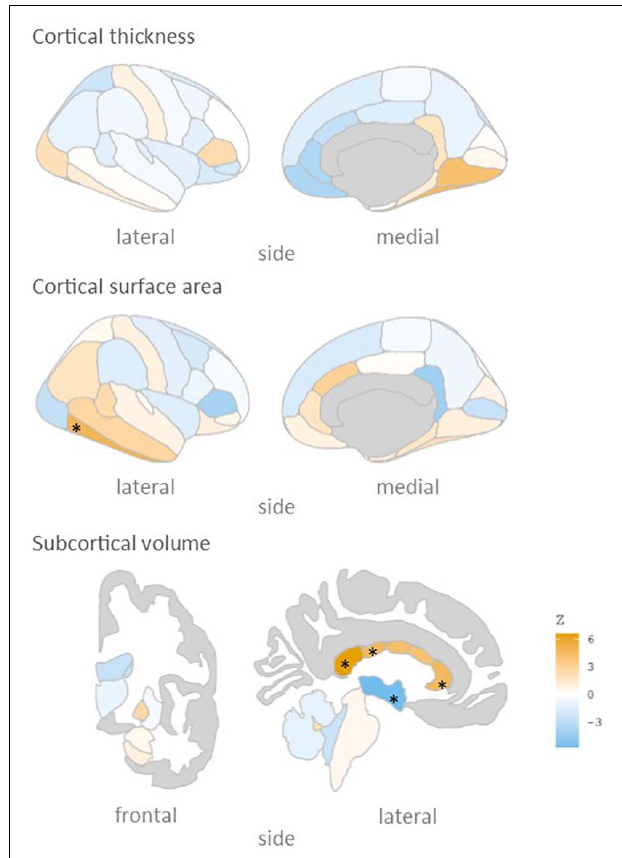
FIGURE 2 | rs5011436 C allele relation to brain morphology. Brain maps showing the spatial distribution of Z scores. Legend colour’s intensity shows strength in correlation. Positive correlation in orange, negative correlations in blue. Stars mark the regions that remain significant after multiple comparisons correction ( p < 0.001). Cortical thickness: no significant regions; cortical surface area: inferior temporal gyrus; subcortical volume: anterior, mid posterior and posterior corpus callosum, and third